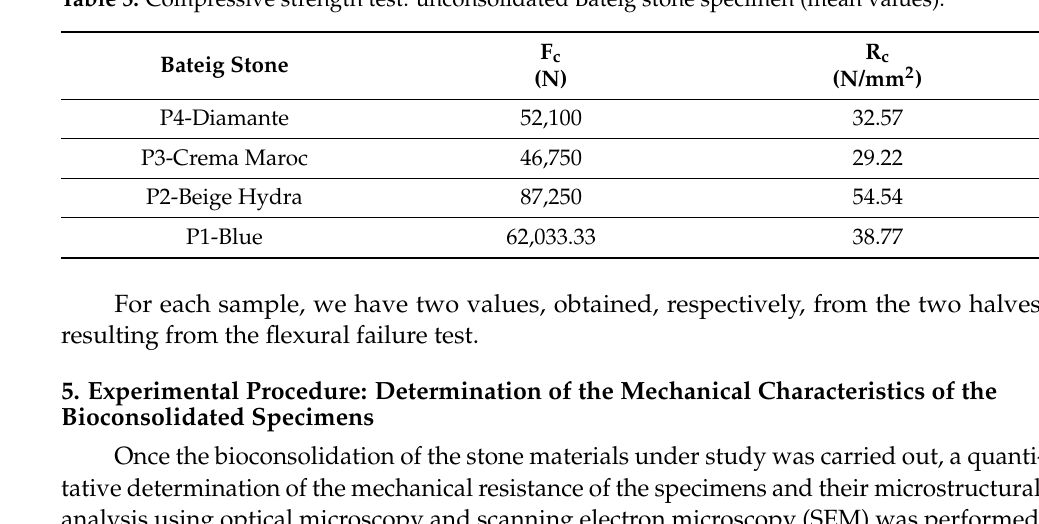
Table 5. Compressive strength test: unconsolidated Bateig stone specimen (mean